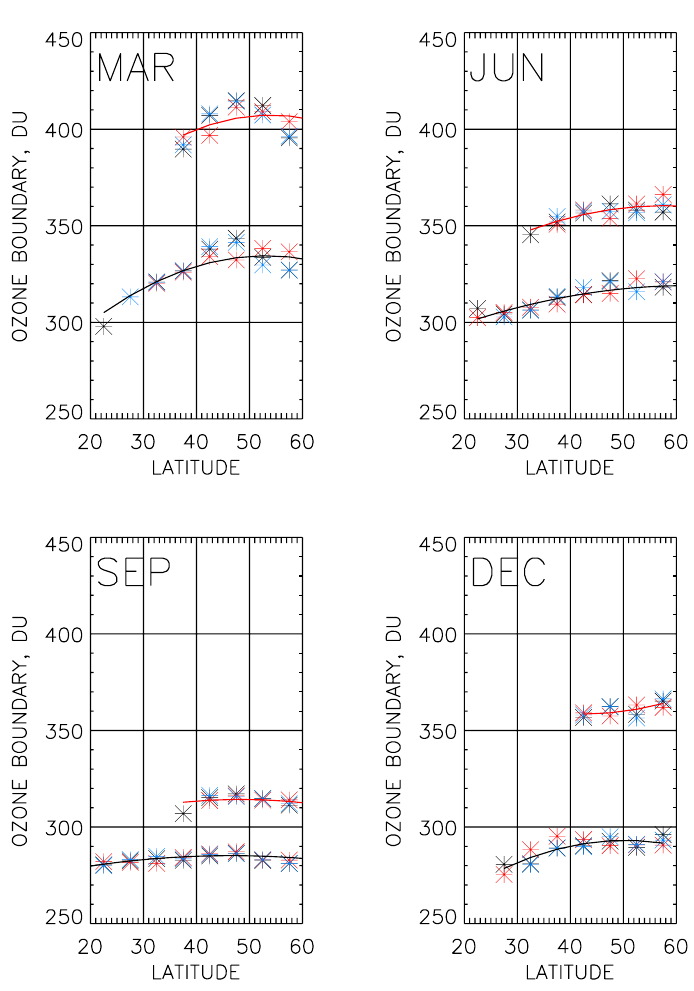
Fig. 3. Derived ozone boundaries from TOMS (red stars), TOVS (blue stars), and OMI (black stars). Data used is for the Northern Hemisphere on the 11 of each month in 2005. On each panel the upper set is for the Polar front, the lower set is for the subtropical front. The solid line is the best fit, using all three instruments, for the subtropical front (black) and the Polar front (red).